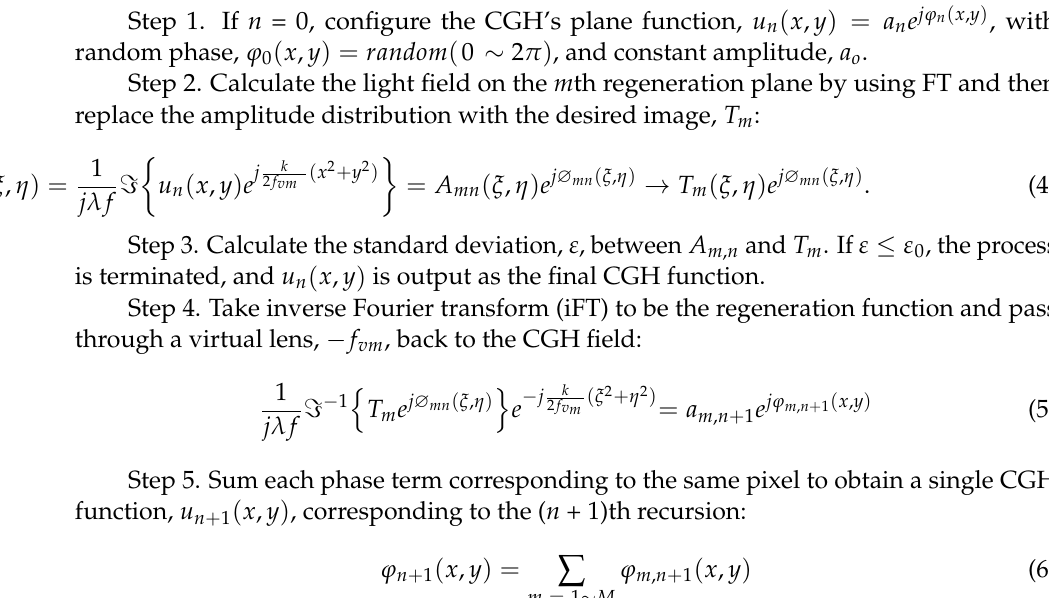
Figure 2. Light field generation away from the real lens’s focal plane by 2D-GSA.